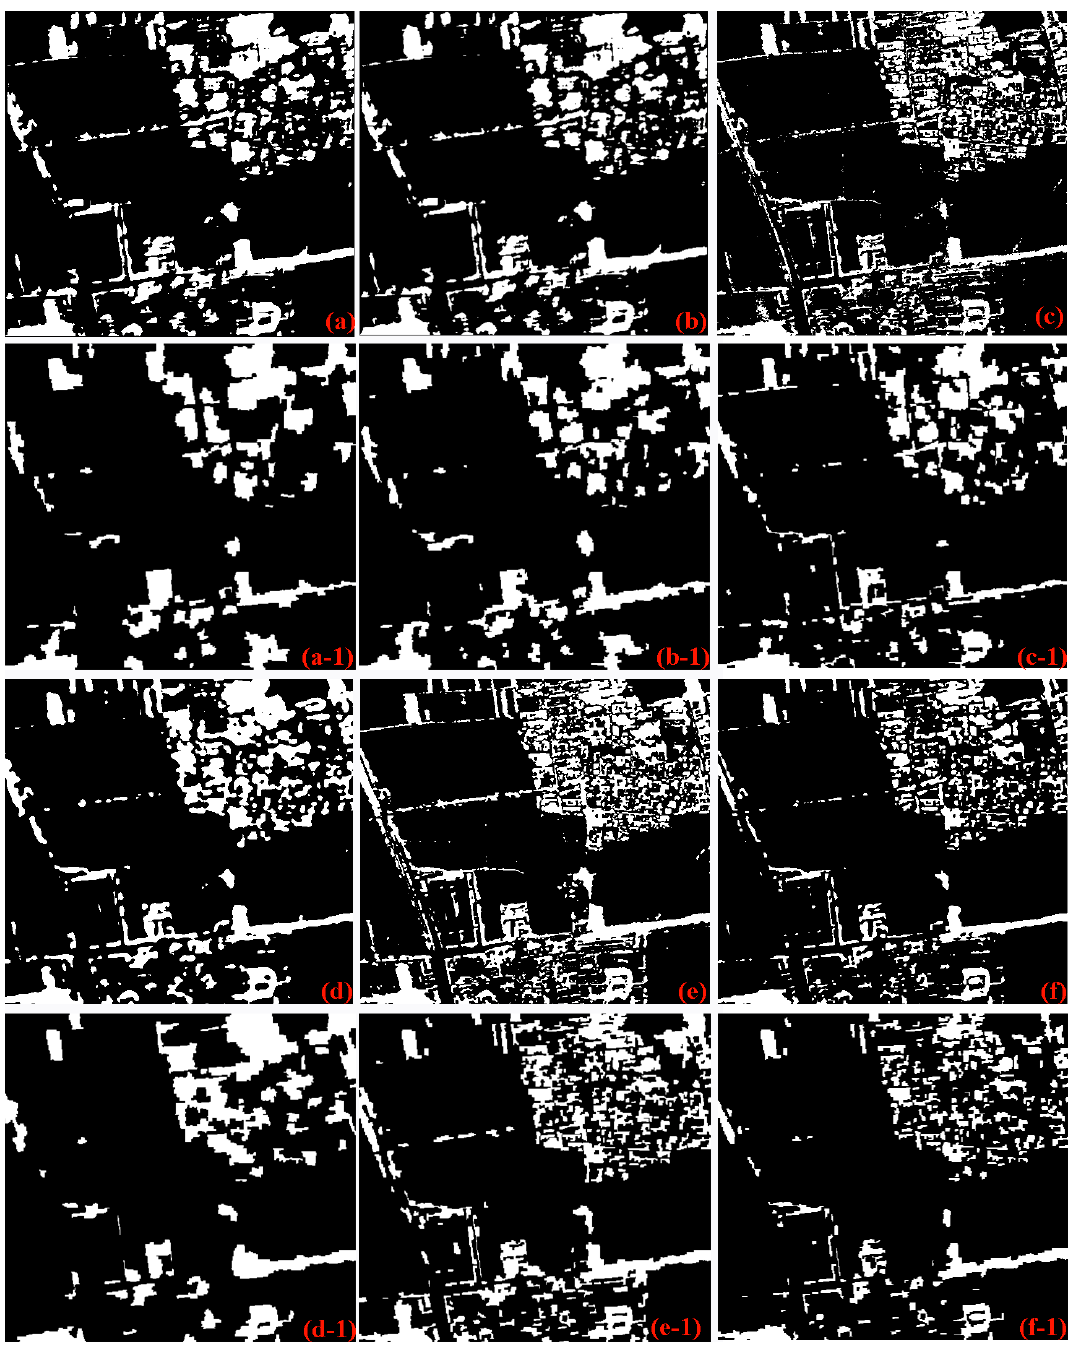
Figure 9. LCCD maps obtained by the preprocessing methods and the proposed OBEM algorithm for the third data set (SPOT-5 images): ( a ) GWDM_EM; ( b ) GWDM_FCM; ( c ) CVA_EM; ( a- 1) GWDM_EM+OBEM; ( b-1 ) GWDM_FCM+OBEM; ( c-1 ) CVA_EM+OBEM; ( d ) MRF_EM; ( e ) LSELUC; ( f ) PCA_Kmeans; ( d-1 ) MRF_EM+OBEM; ( e-1 ) LSELUC+OBEM; and ( f-1 ) PCA_Kmeans+OBEM.